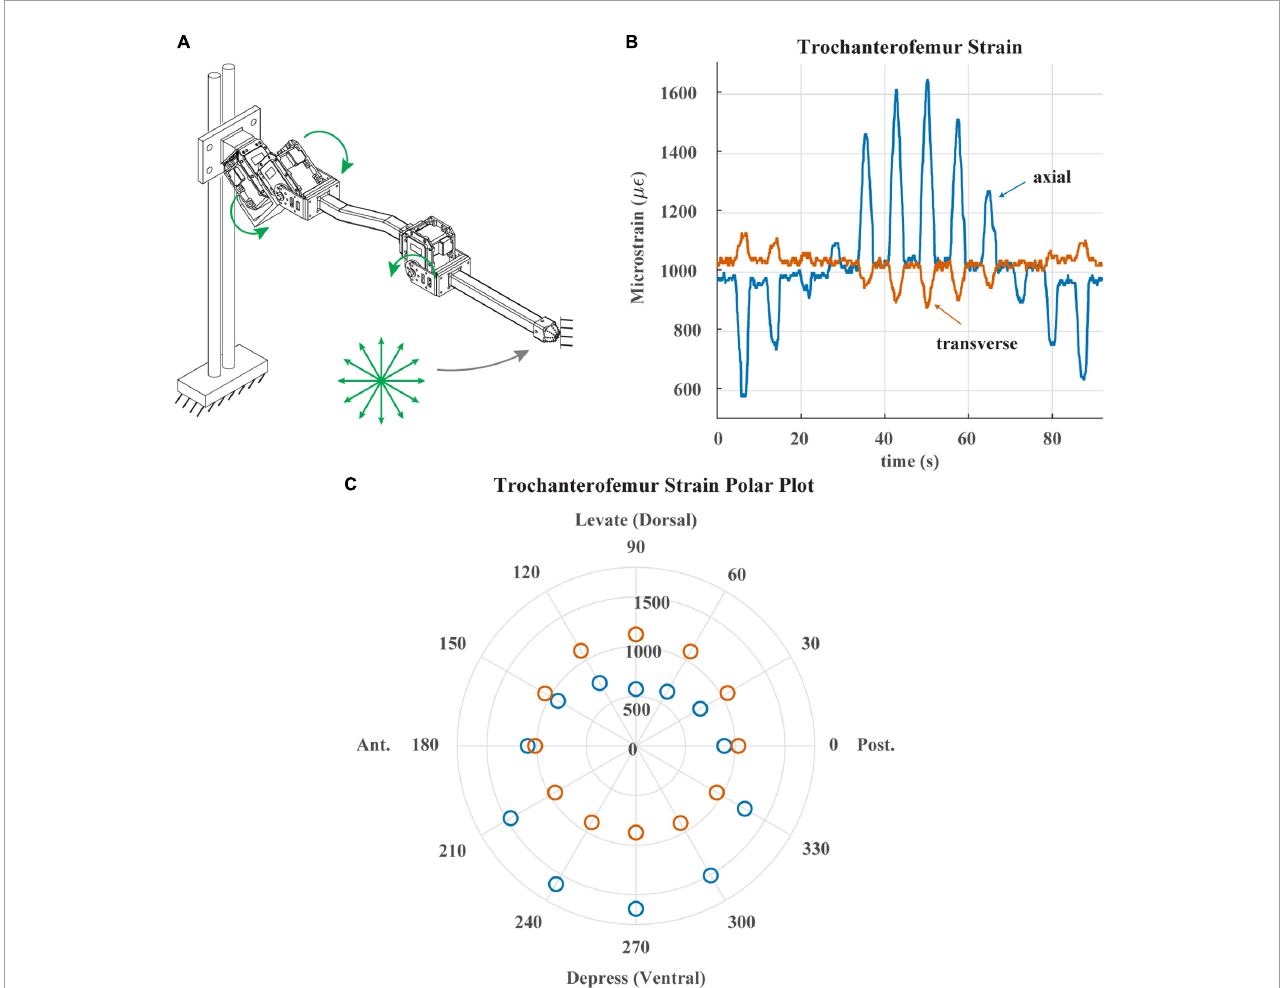
FIGURE5 (A) Diagram of robotic leg configuration. Green arrows show type and direction of movement for the servomotors. Distal end of leg is fixed in place and the leg is commanded to draw a 12-point asterisk shown with green arrows. (B) Trochanterofemur strain output when distal end of leg is fixed, and the robotic leg is commanded to draw an asterisk pattern. The leg would return to the center of the asterisk before moving to the next position. (C) Polar plot of the trochanterofemur strain data with anterior, posterior, dorsal and ventral sides of robotic leg